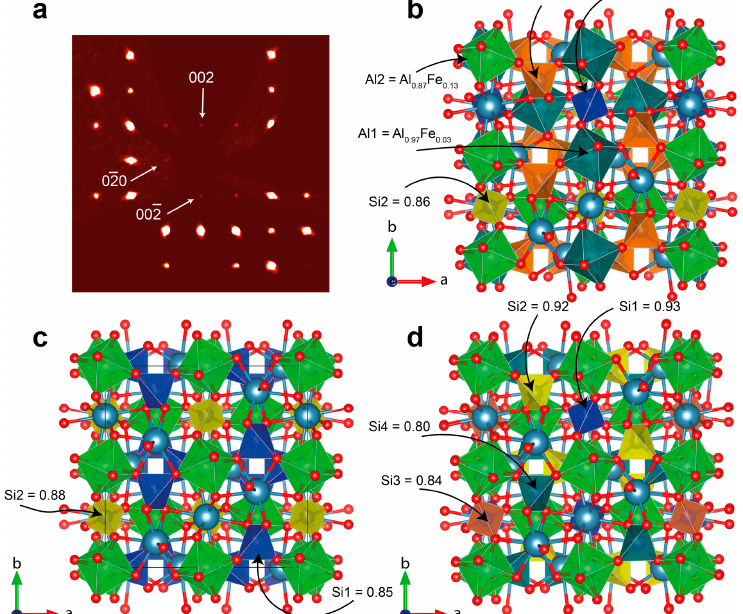
Figure 4. Reconstructed section (0 kl ) of reciprocal space obtained for (H 4 O 4 ) 4 − -substituted grossular. Arrows indicate reflections violating the h 00 condition ( h = 4 n ) for 00 l - and 0 k 0-type reflections related to the 4 1 axis parallel to [001] and [010], respectively ( a ). Projection of the crystal structure of (H 4 O 4 ) 4 − -substituted grossular along the c axis: the I 4 1 / a model ( b ), the I 4 1 / acd model ( c ), the I 4(cid:3364)2 d model ( d ).